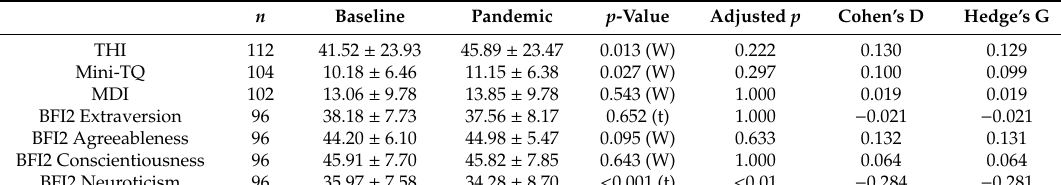
Table 2. Comparison between the pandemic situation and the baseline. Mean values are given ± standard deviation. W: paired Wilcoxon test, t : paired t -test.